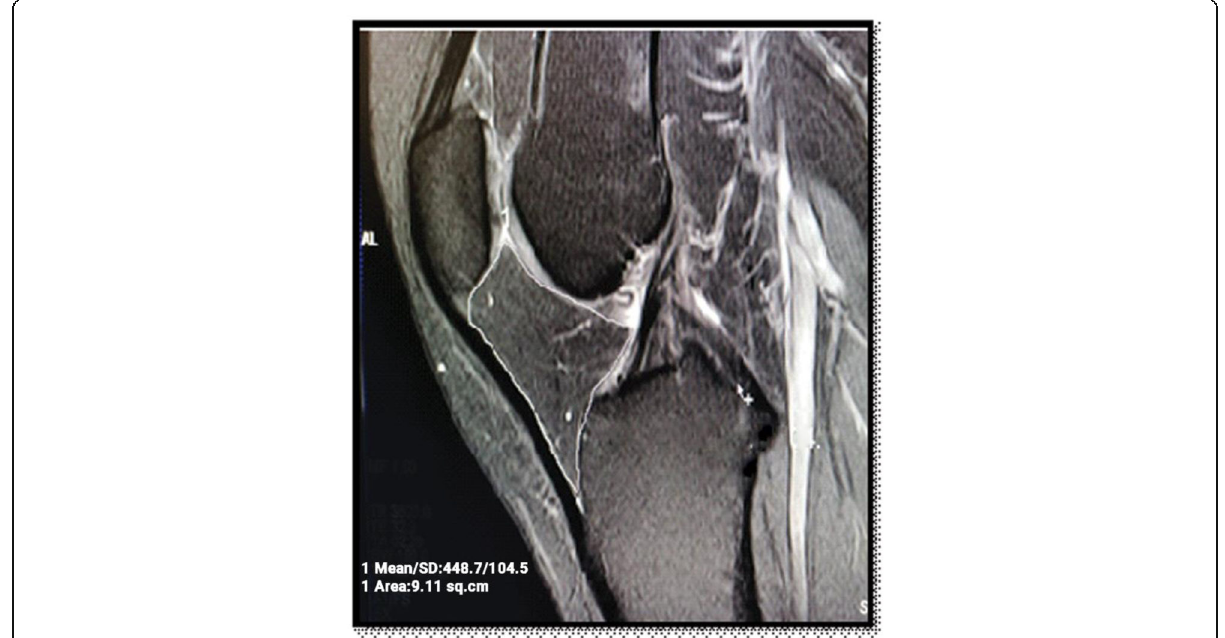
Fig. 2 Measurement of the infrapatellar fat pad area on MRI. a Sagittal T2WI with fat saturation showing manual tracing of the boundaries of the IPFP (the maximum area represents the infrapatellar fat pad area in square